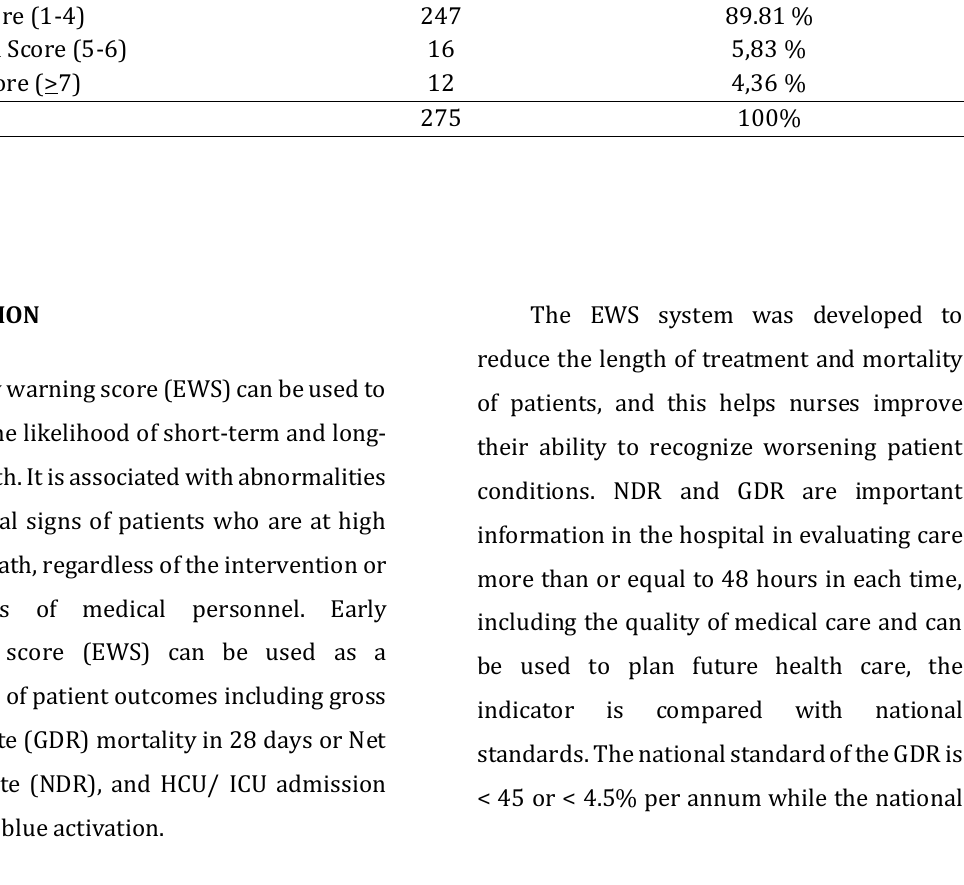
Frequency distribution of EWS in the intervention group Score